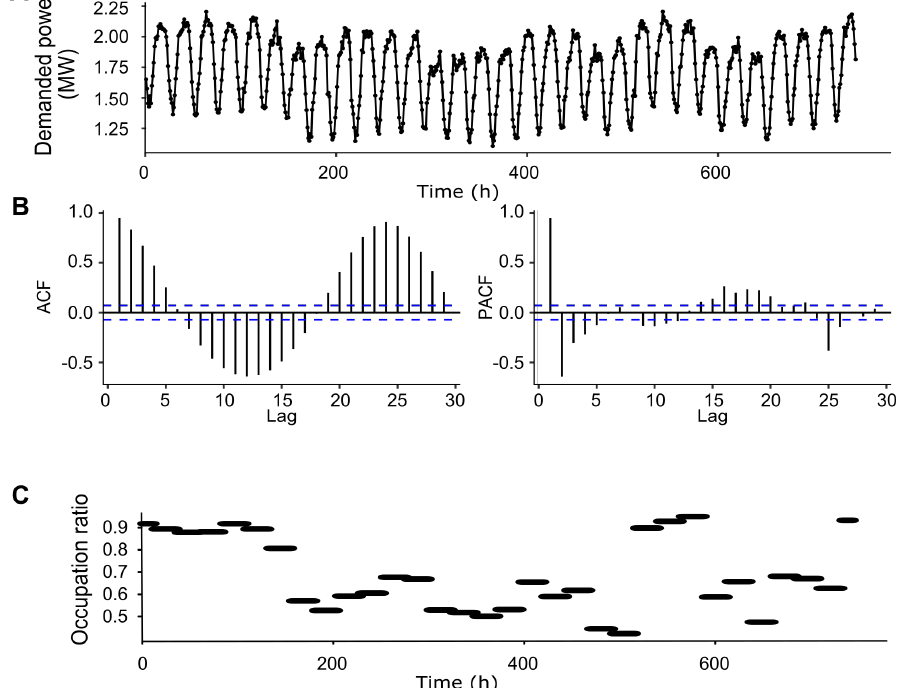
Figure 2. Demanded power by a hotel. ( A ) Demanded power by a hotel for 31 days. ( B ) Auto-Correlation Function and Partial Auto-Correlation Function of demanded power in ( A ); dashed blue lines indicate significance bounds. ( C ) Occupation ratio of the hotel during same